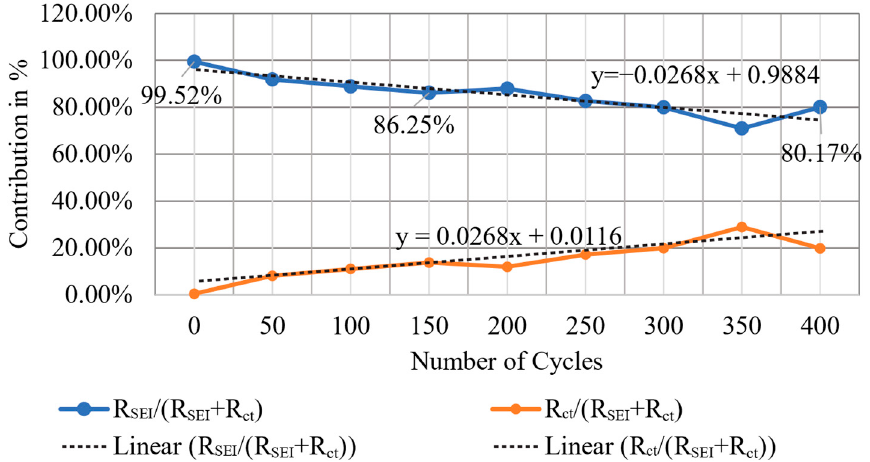
Figure 11. Contribution of RSEI, respectively R ct to R ct +R SEI for cell one as a function of the number of cycles.